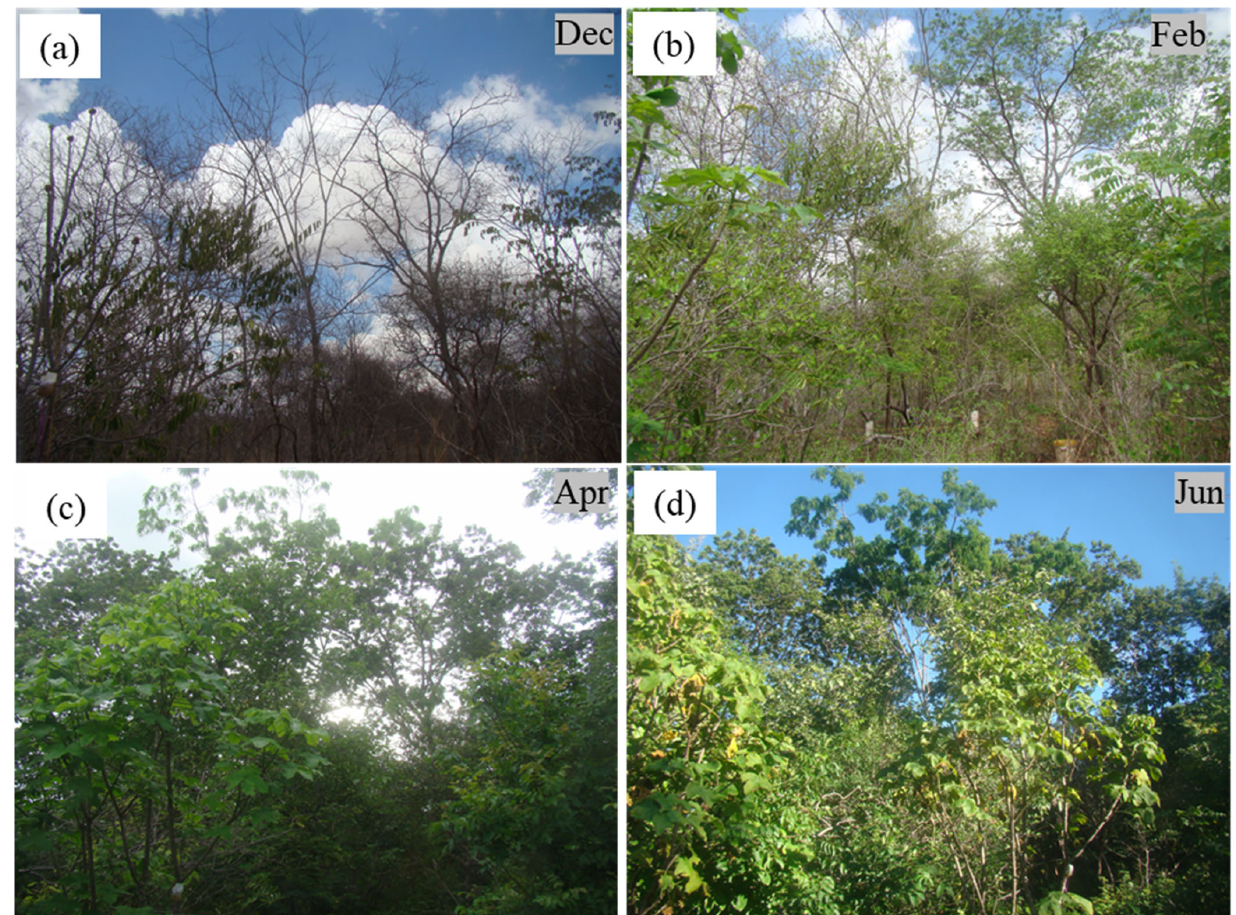
Figure 3. Photographic records of changes in leaf density during the study period: ( a , b ) during leaf development, ( c ) at maturity, and ( d ) during the fall period. Photos by the author.